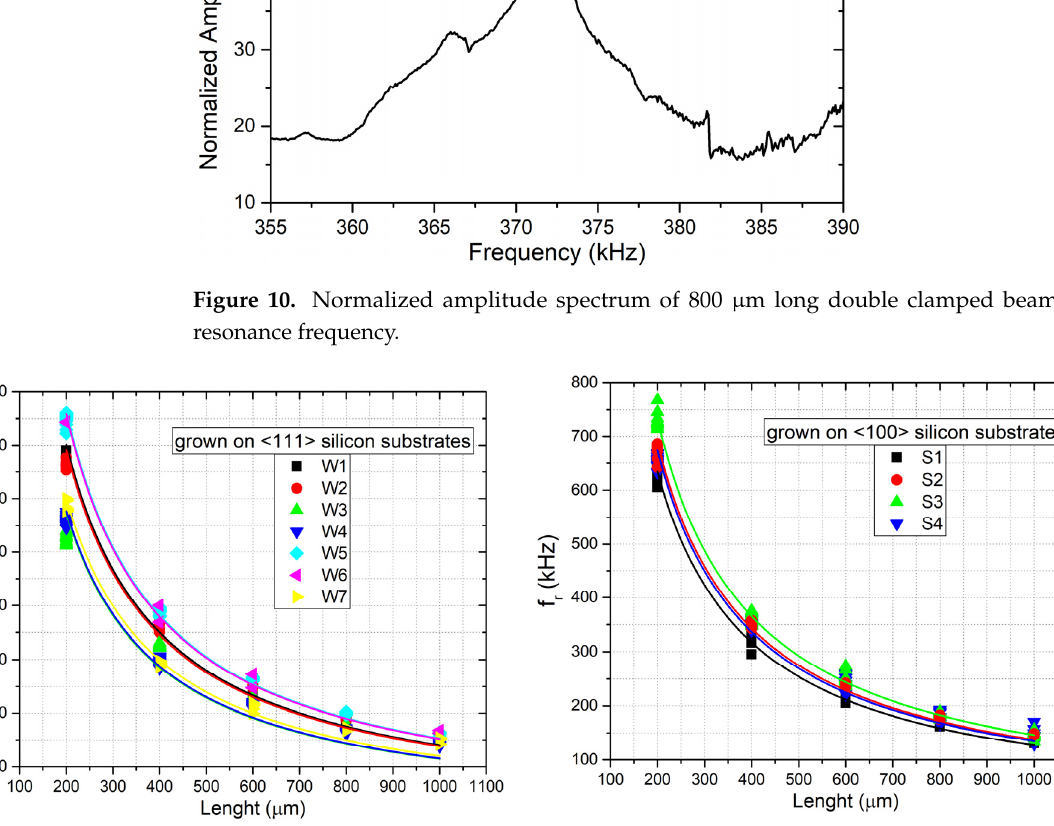
Figure 10. Normalized amplitude spectrum of 800 µm long double clamped beam around its reso- nance frequency.